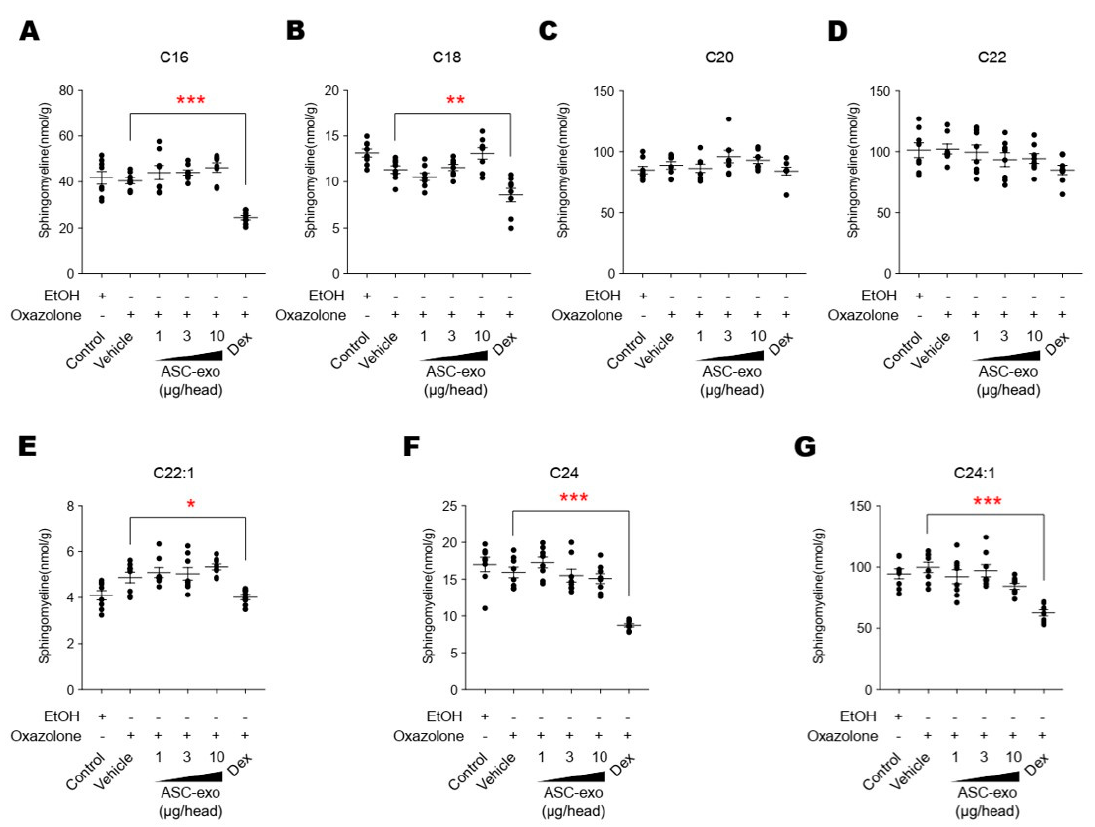
Figure 10. ASC-exosomes do not affect the sphingolipid hydrolysis pathway. ( A–G ) The lipid profiles were determined by LC-MS/MS measurements. Note that dexamethasone treatment significantly reduces the levels of sphingomyeline except for those with C18 and C20 acyl chains. Error bars depict the SEM. n = 8. *: p < 0.05, **: p < 0.01, ***: p < 0.001 vs. vehicle. Dex, dexamethasone.